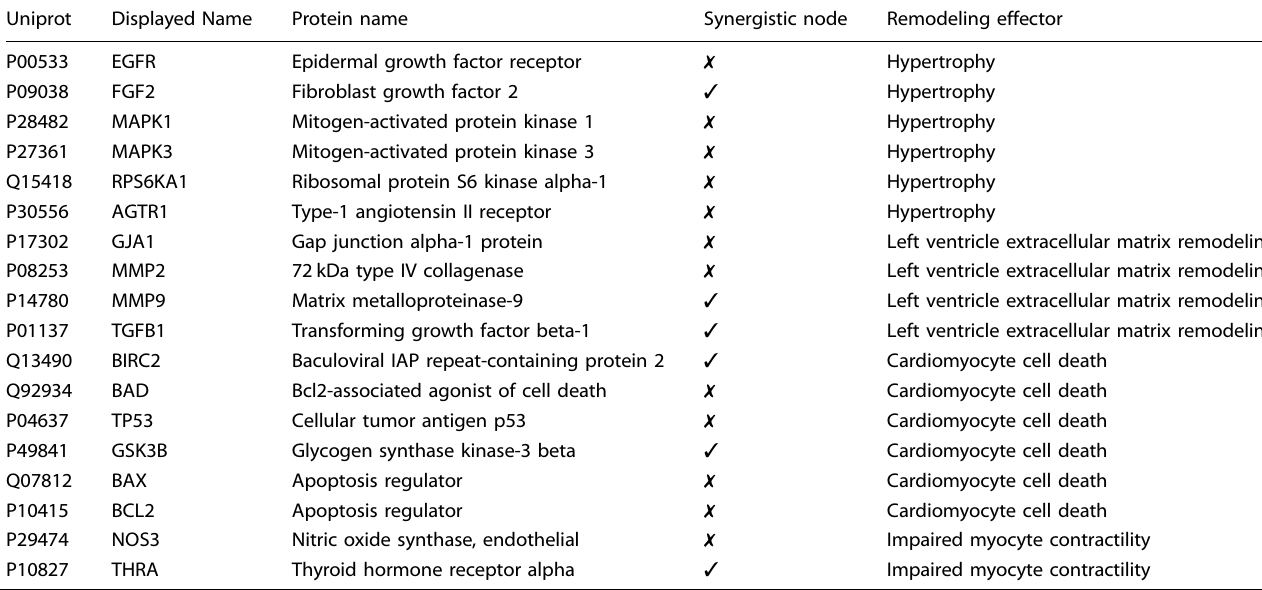
Table 2. Protein effectors of cardiac remodeling included in the MoA representation